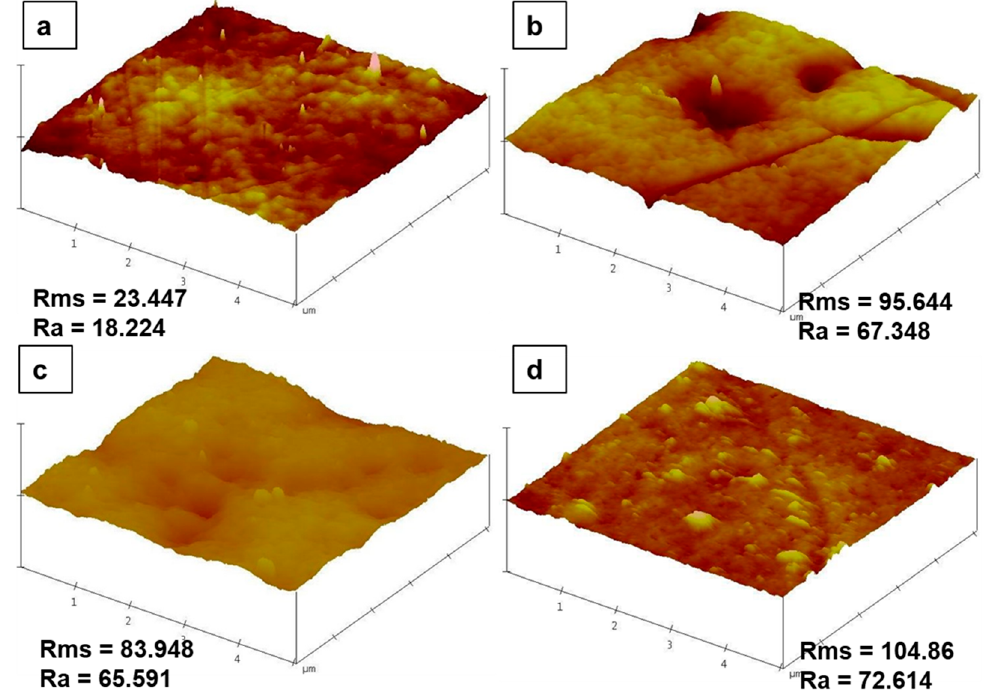
Figure 6. AFM surface topology and roughness for the membranes prepared in this study: ( a ) PES0, ( b ) A0, ( c ) A1, and ( d ) A2. The surface roughness parameters R ms and R a refer to the root square and area mean roughness measurements in nm, respectively.